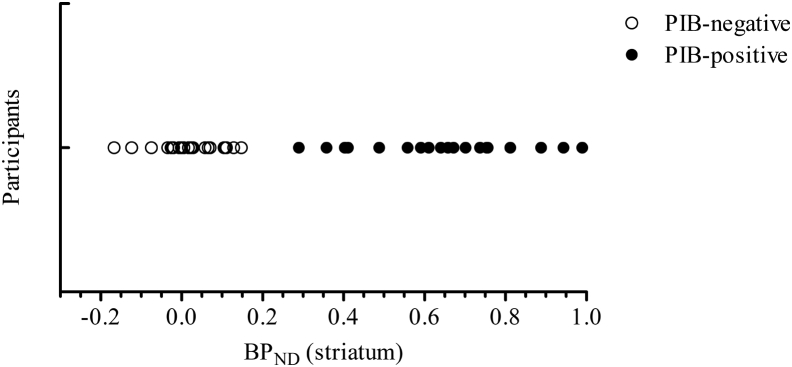
A scatter-plot representation of striatal non–displaceable binding potential for all participants, demonstrating the presence of two distinguishable populations. Classification of the two groups—PIB-positive and PIB-negative—was based on visual inspection of the data presented in this figure. Abbreviations: PIB, Pittsburgh compound–B; BPND, non–displaceable binding potential.